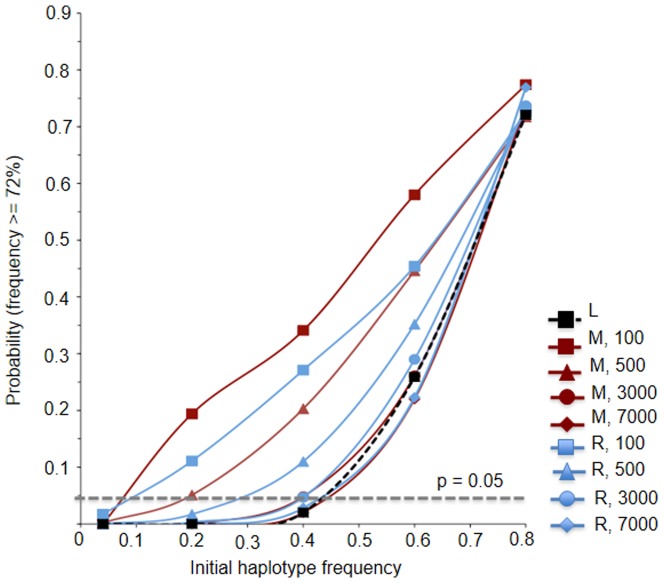
The probability that the expected haplotype frequency for the most common haplotype is equal to or greater than the observed frequency of 0.72.Shown are the models described in Fig. 2 left (L), middle (M) and right (R) considering various levels of population size reductions to Nei = 100, 500, 3,000 and 7,000. The grey dashed line indicates the probability of 5% of the most common haplotype to reach a frequency ∼0.72 or higher.